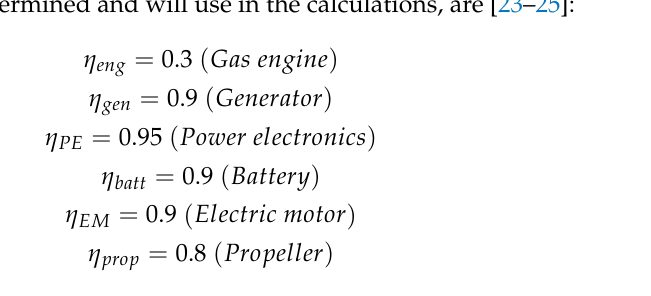
Table 1. Values of hybrid variables. Source: [23]. Variable Value 0 Value 1 The entire aircraft weight No weight on the aircraft is consists only of battery Energy weight fraction ( β ) dedicated towards the battery and/or liquid fossil fuels. and/or liquid fossil fuels. Aircraft is fully powered Batteries fully power Percent hybrid (x) by gasoline. the aircraft. Charging fuel weight fraction All the fuel onboard is used All the fuel on board is used ( α ) fraction for propulsion. to charge the